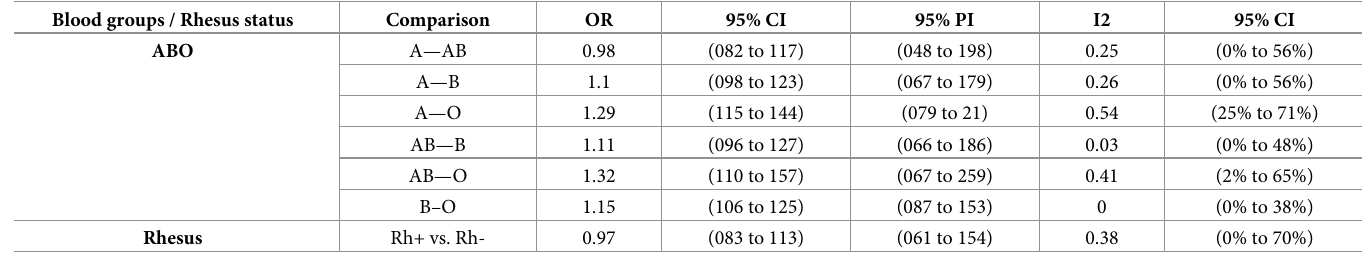
Table 2. Meta-analysis